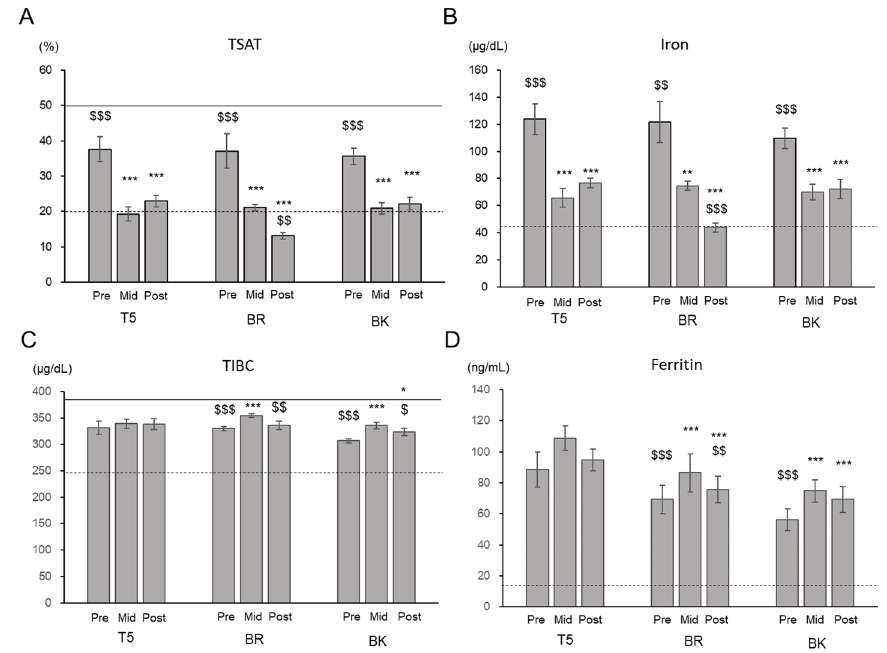
Figure 1. Changes in iron parameters. ( A ) Transferrin saturation (TSAT), ( B ) serum iron level, ( C ) total iron-binding capacity (TIBC), and ( D ) ferritin level. T5, Tight-5 (numbers 1–5); BR, Back row (numbers 6–8); and BK, Backs (numbers 9–15). Bars and error bars represent estimated marginal means and standard error, respectively. The solid and dashed lines indicate the upper and lower limits of the normal range, respectively. * p < 0.05, ** p < 0.01, *** p < 0.001 vs. Pre; $ p < 0.05, $$ p < 0.01, $$$ p < 0.001 vs. Mid.